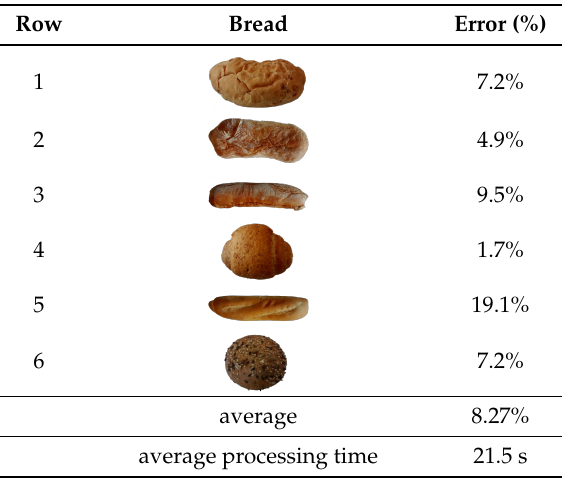
Table 1. Error rate in the reconstructed models’ volume estimations for solid